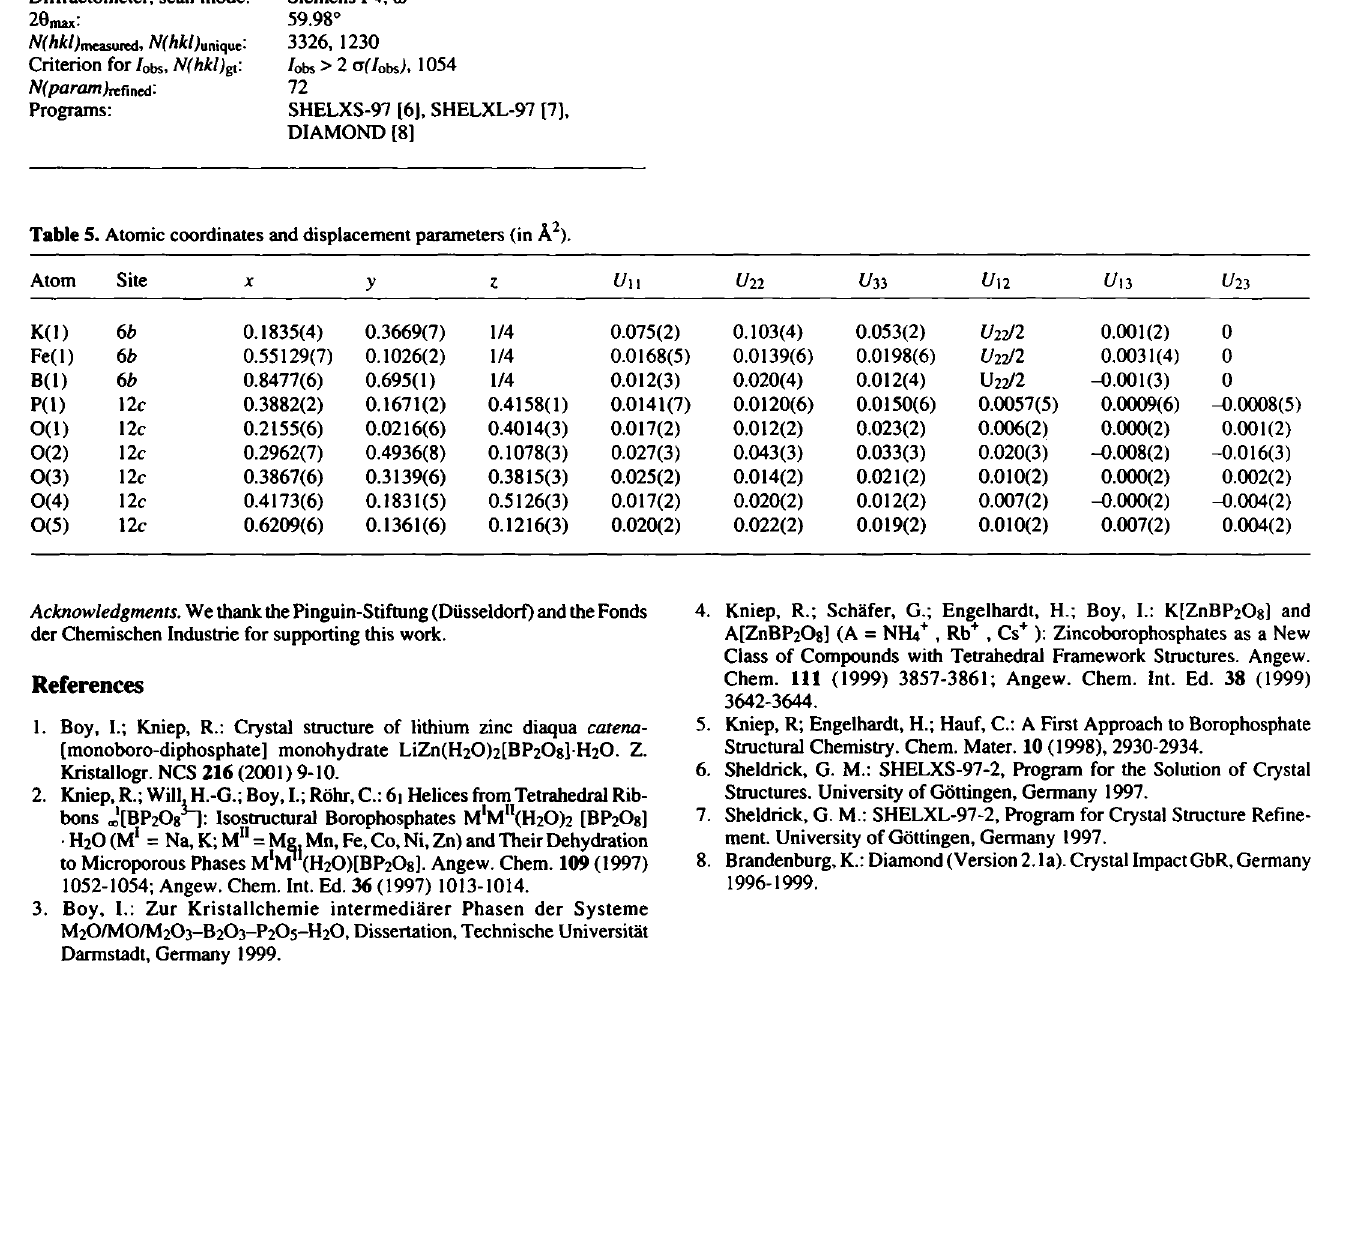
Table 3. Data collection and handling. Table 4. Atomic coordinates and displacement parameters (in A 2 ).